Question: What does this figure show? Answer in one sentence.
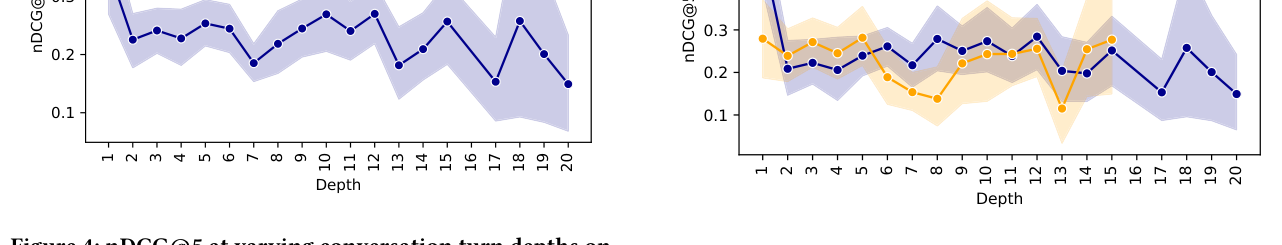
Answer: nDCG@5 at varying conversation turn depths on the passage ranking task, for turns that depend on PTKB statements vs. those that do not. We report the average across runs, median or better.